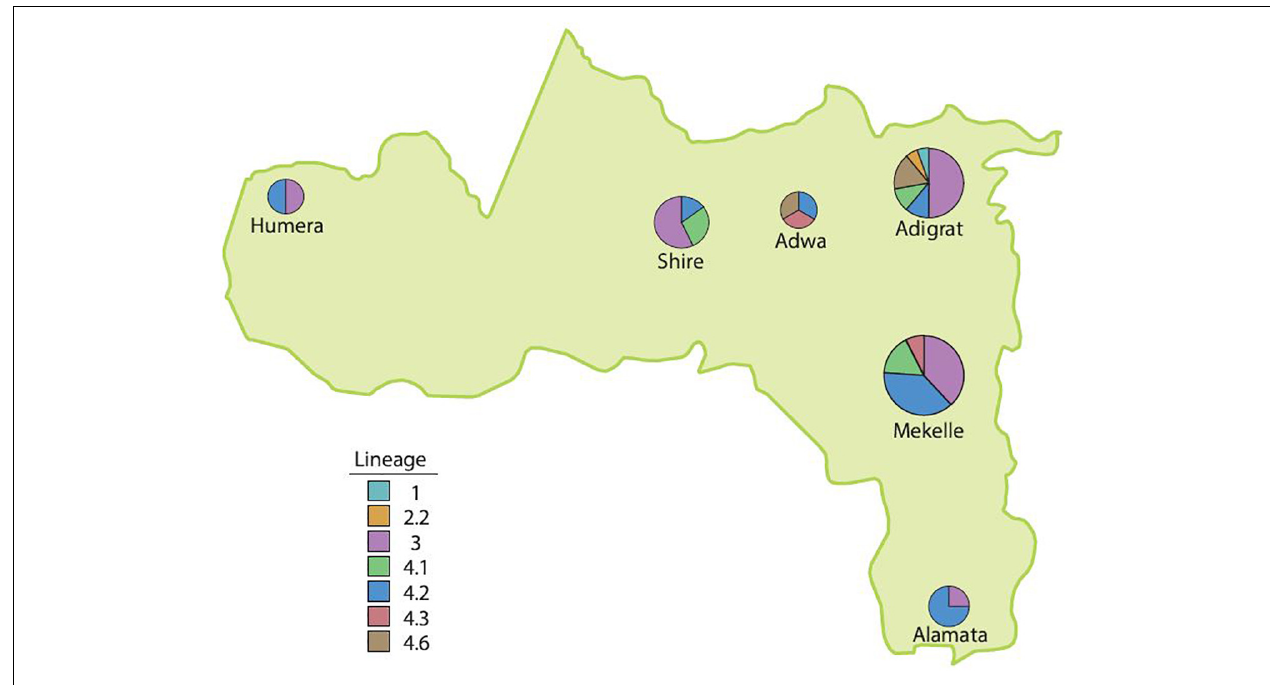
FIGURE 3 | The distribution of lineages in the Tigray Region, Ethiopia, July 2018–August 2019.